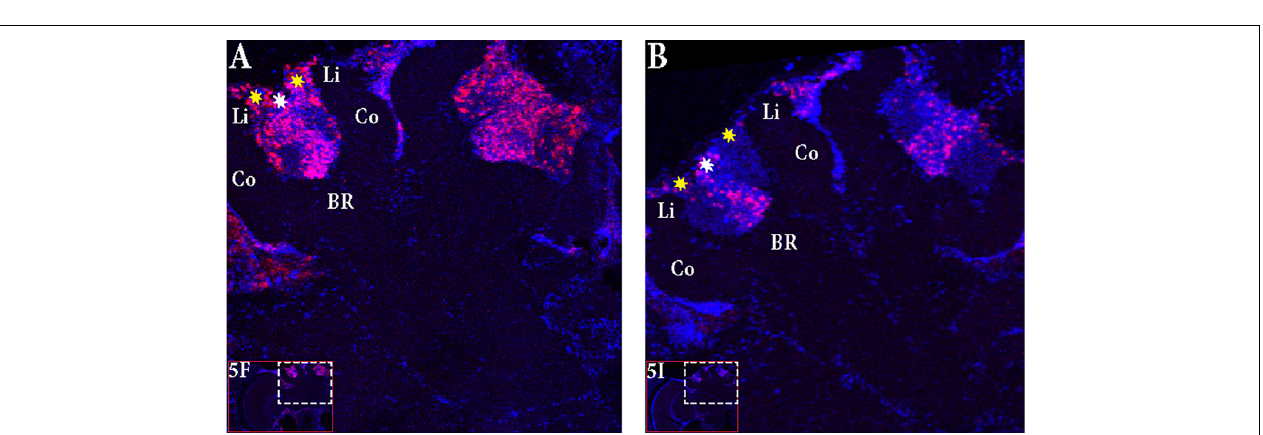
FIGURE 6 | Focus on the mushroom bodies of the “active foragers” and the “non-active foragers”. (A) Almost all the small Kenyon cells (white stars) are stained for Egr-1 whereas only some of the large Kenyon cells (yellow stars) that are closer to the calyces show staining in the “active foragers”. (B) “Non-active foragers” showed very specific staining of the small Kenyon cells (white stars) and a few cells close to the “lip” region of the calyces only. Li, Lip; Co, Collar; BR, Basal Ring.